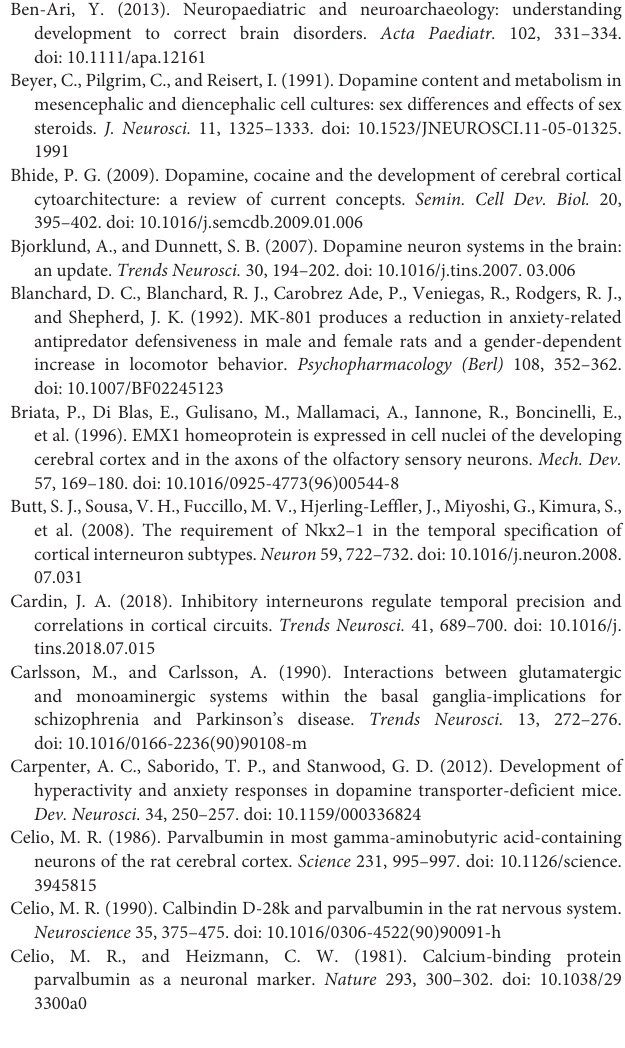
SUPPLEMENTARY FIGURE 1 | Regional description of recombination patterns. Emx1 -Cre and Nkx2.1 -Cre mice were bred to the B6.Cg-Gt(ROSA)26Sortm14(CAG-tdTomato)Hze line. Offspring express bright